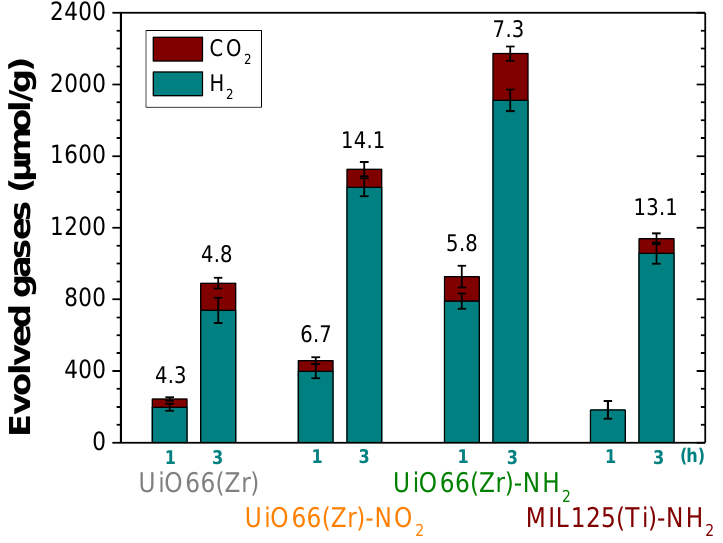
Figure 5. Photocatalytic H 2 and CO 2 generation from glycerol aqueous solution using the MOFs under study. The numbers indicated above the bars correspond to the H 2 -to-CO 2 molar ratio. Reaction conditions: Photocatalyst (5 mg), H 2 O:glycerol mixture (20 mL; 14 vol%), reaction time as indicated, simulated sunlight irradiation (230 W/cm 2 ), 35 °C.